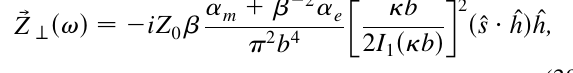
=b (cid:5) 0 : 5 ; 0 : 75 ; 0 : 9 h